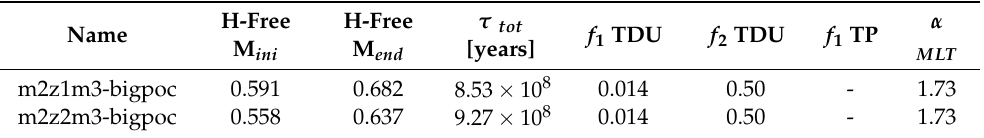
Table 3. Same as in Table 2, but for our 2 M (cid:12) AGB models. m2z1m3-bigpoc and m2z2m3-bigpoc have an initial metallicity of Z = 0.001 and Z = 0.002,